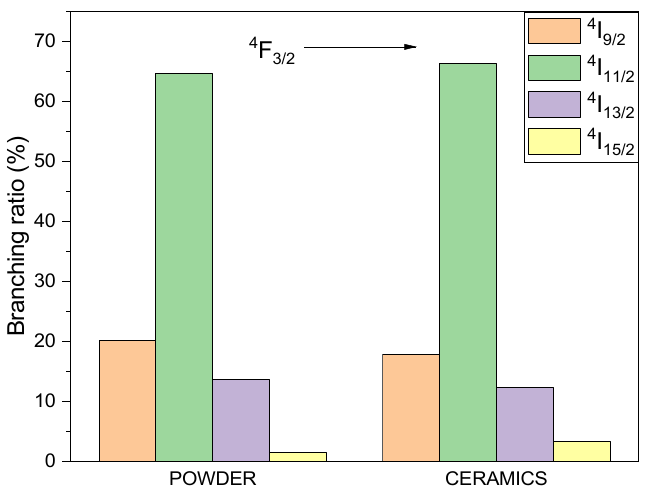
Figure 12. The visualization of the branching ratio between the Nd 3+ emissions in BMW hosts. The differences in luminescent properties between powdered and SPSed samples are mainly due to three reasons.